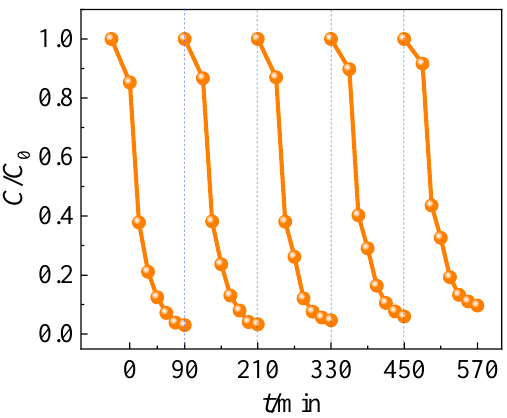
Figure 8. Cyclic degradation results of methyl orange by TiO 2 -6%RGO.